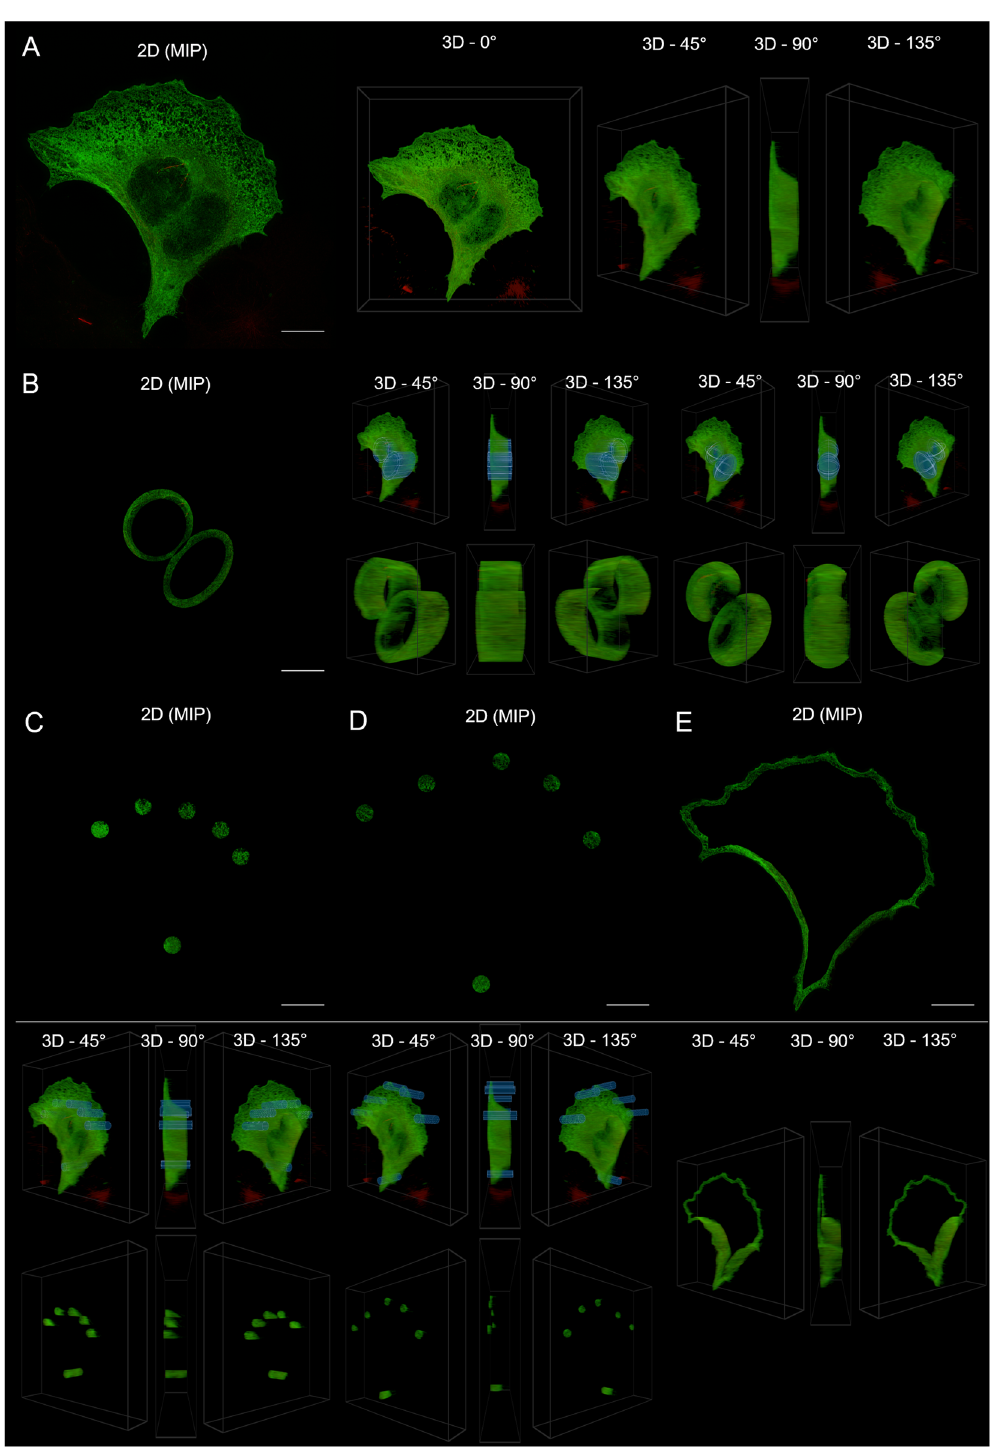
Fig 1. The main ROIs analyzed. Comparison of the MIP and the 3D visualization of some of the main regions analyzed for colocalization. The 3D image shows the selection overlaid on the whole cell, as well as the selection isolated from the remainder of the cell. The depicted cell is from the control sample set ( t = 0). A: The whole cell. B: The perinuclear region for both a cylindrical and ellipsoidal selection. C: The sampled middle region. D: The sampled membrane region. E: The freehand membrane region (no overlay